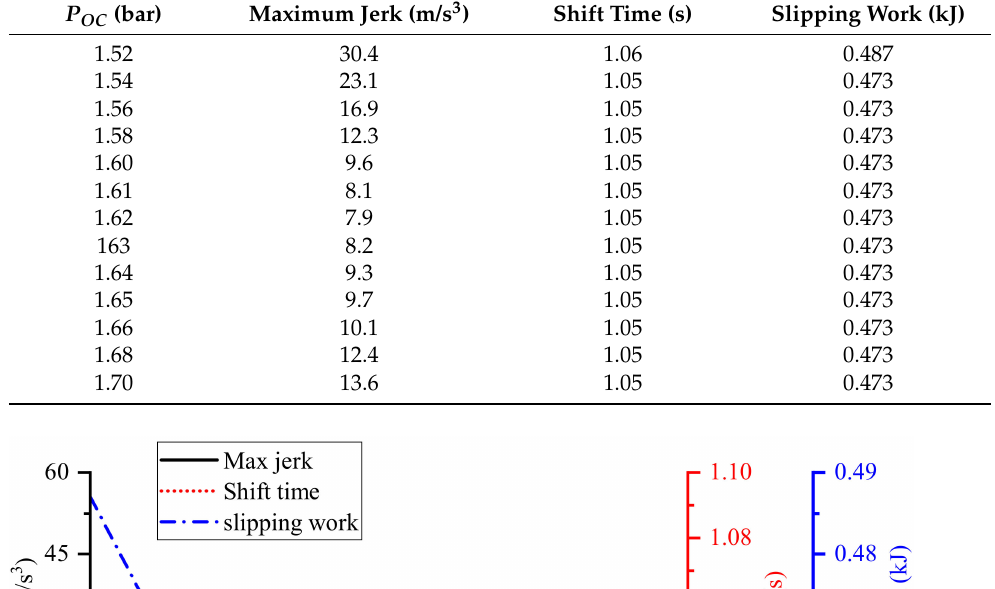
Table 2. Shift evaluating indexes under different P OC .